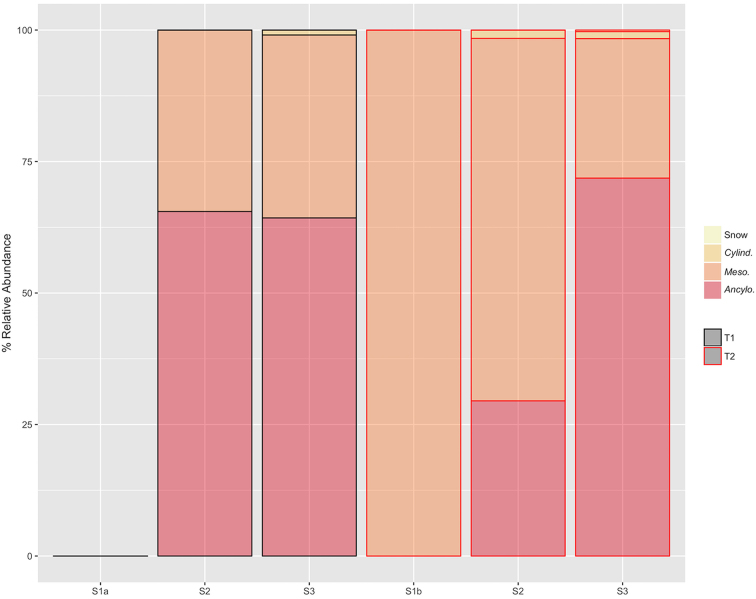
The relative abundance of Ancylonema nordenskiöldii (Ancylo.), Mesotaenium berggrenii (Meso.), Cylindrocystis brebissonii (Cylindro.) and snow-algal resting spores (Snow) apparent across sampling sites during transect 1 (T1) and transect 2 (T2).